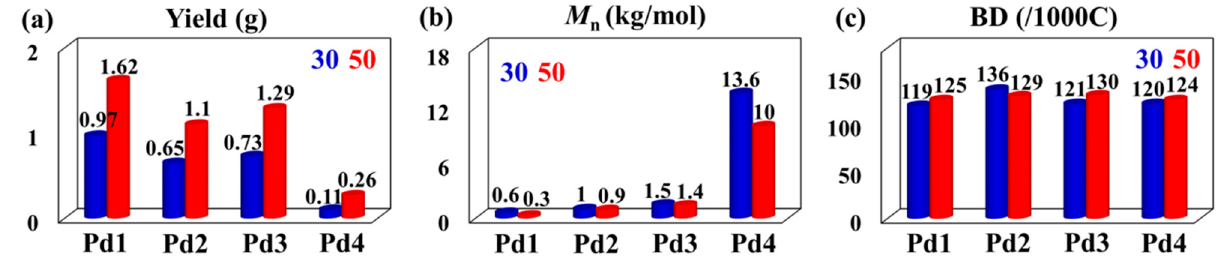
Figure 1. Comparisons on yield ( a ), molecular weight ( b ), and branching density ( c ) of propylene oligomers or polypropylene yielded with catalysts Pd1 − Pd4 at 30 o C (blue) and 50 o C (red).